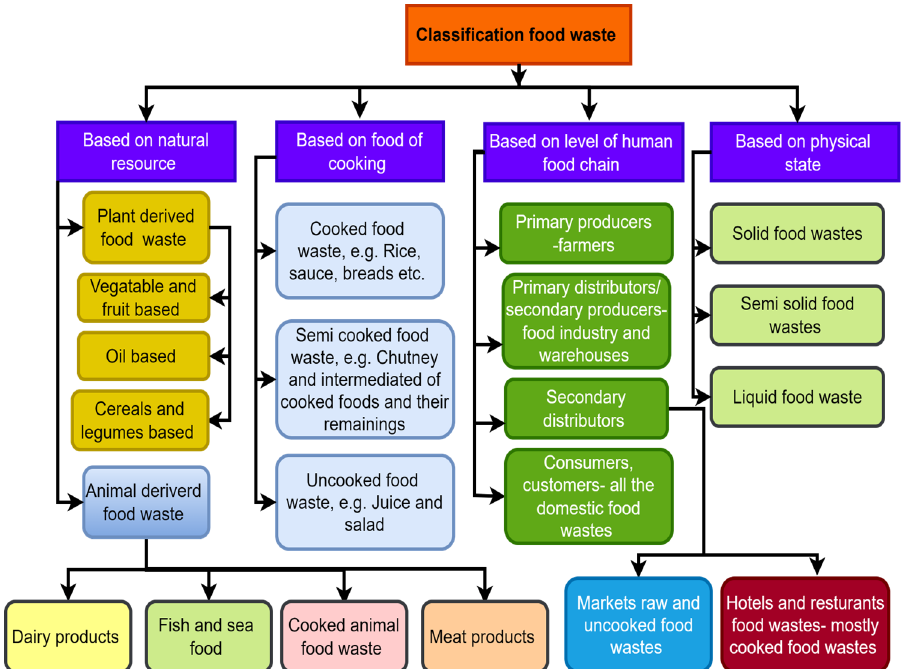
Figure 1. Overview of classification of FW.